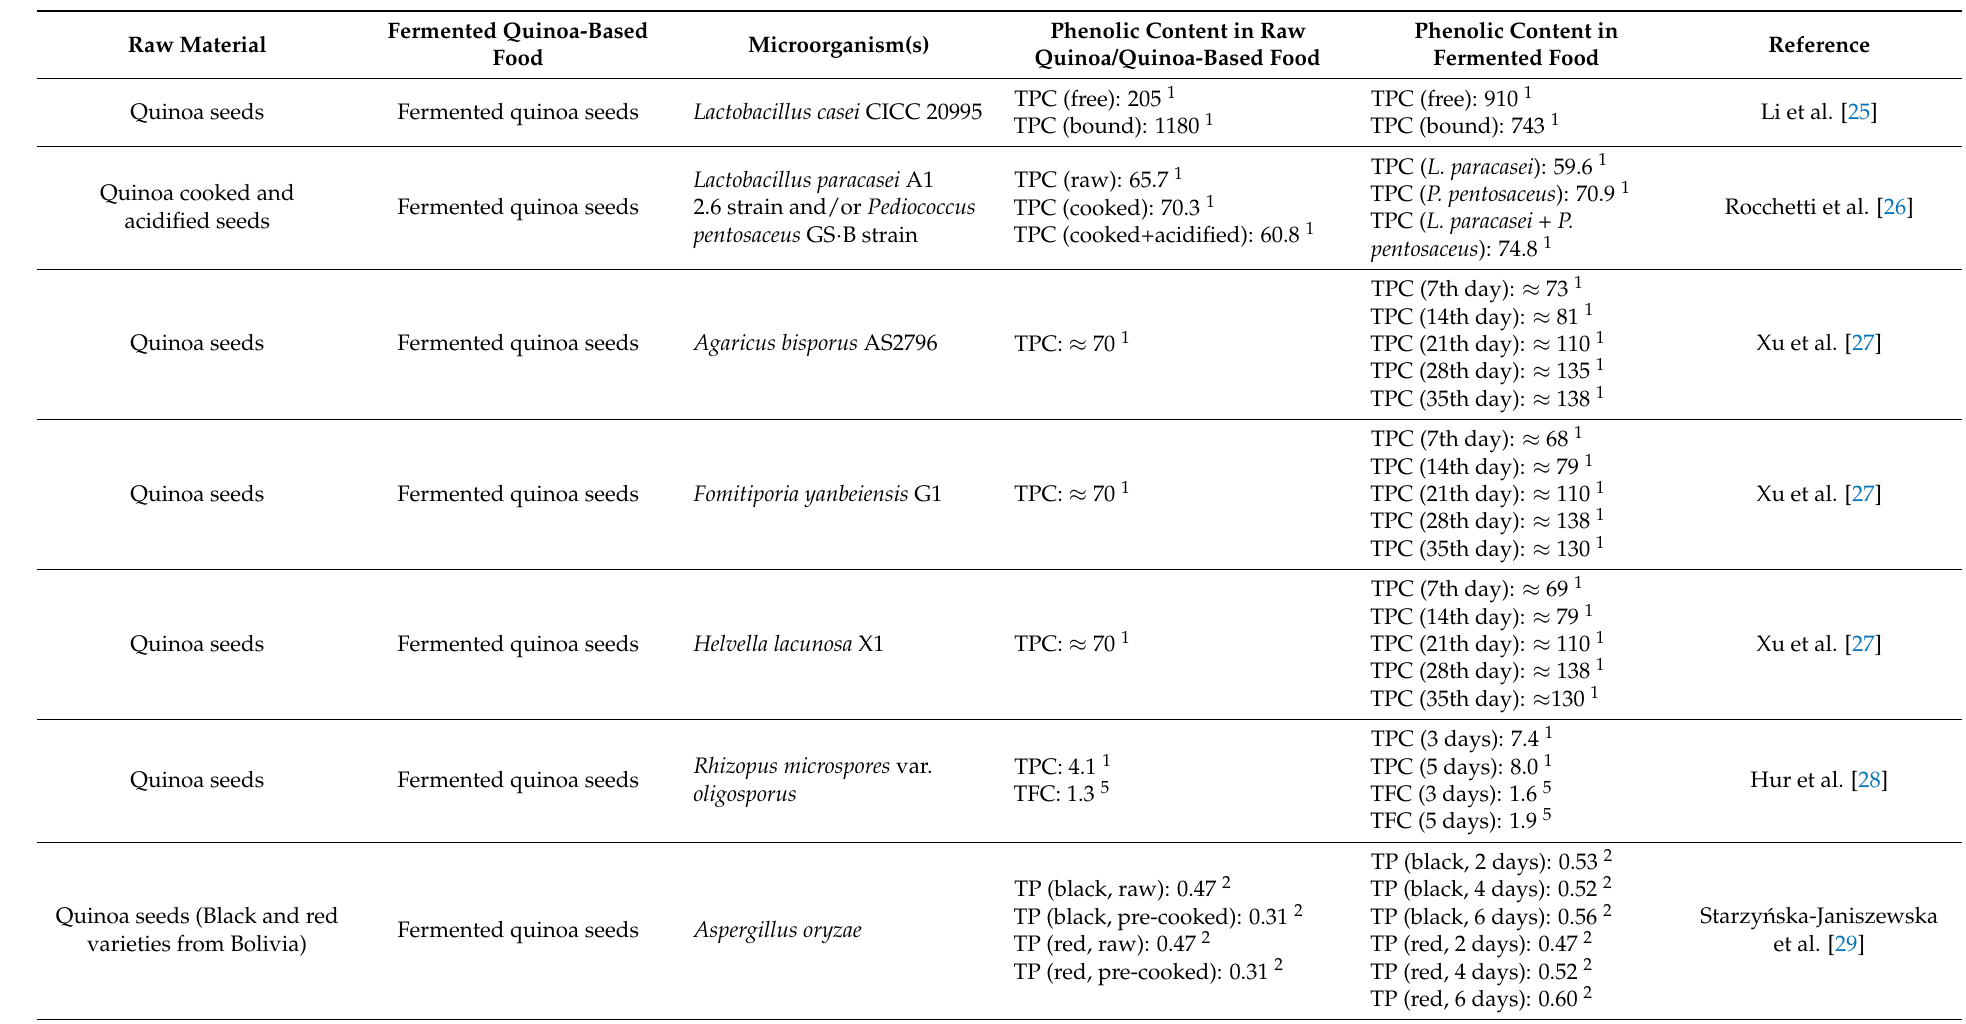
Table 1. Effect of fermentation on phenolic content in quinoa-based fermented